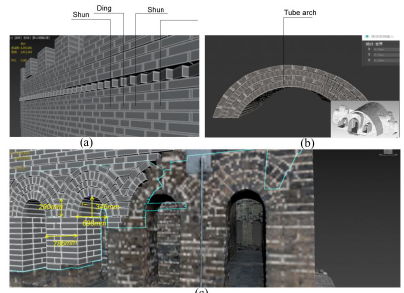
Figure 8. The geometry information of battlement